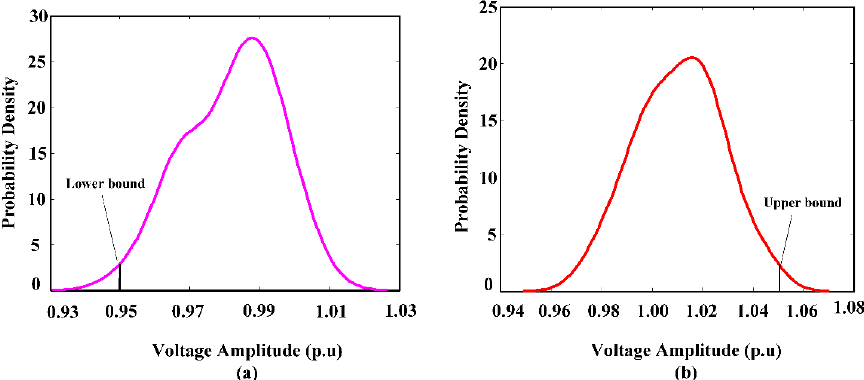
Figure 8. PDF curve of voltage amplitude in Scenario B of 33 ‐ bus system: ( a ) Node 32; ( b ) Node 4.